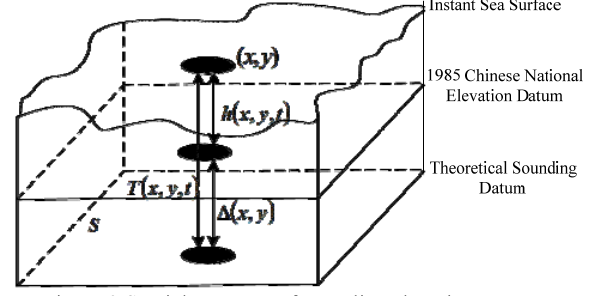
Figure.2 Spatial structure of waterline